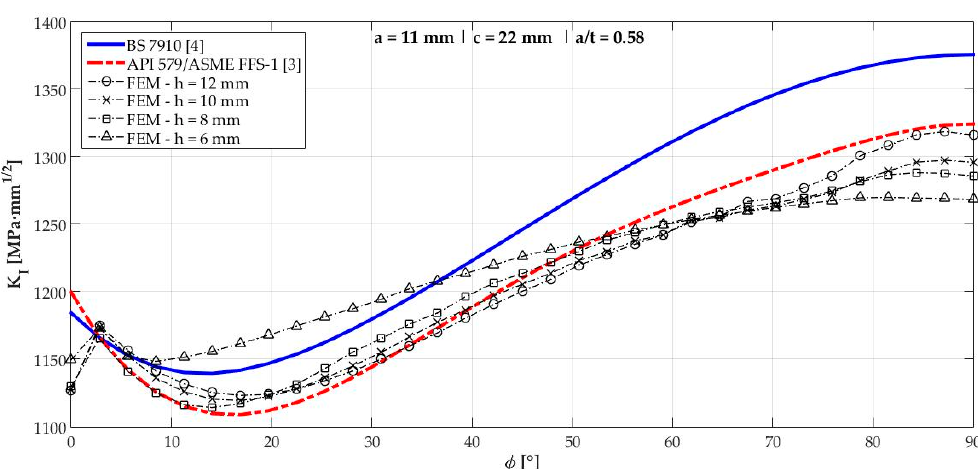
Figure 8. Mode I SIF profiles for crack 3 ( a = 11 mm , c = 22 mm , and a/t = 0.58 ).